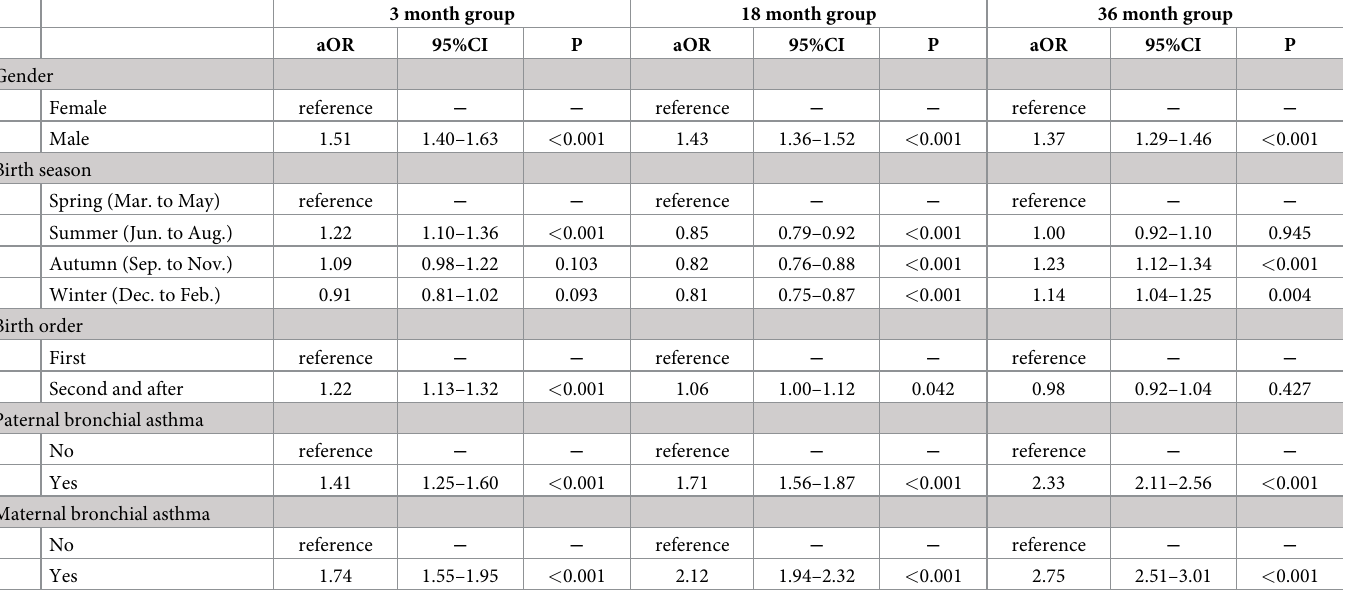
Table 5. Multivariable analysis between wheeze and covariates in the three age groups.